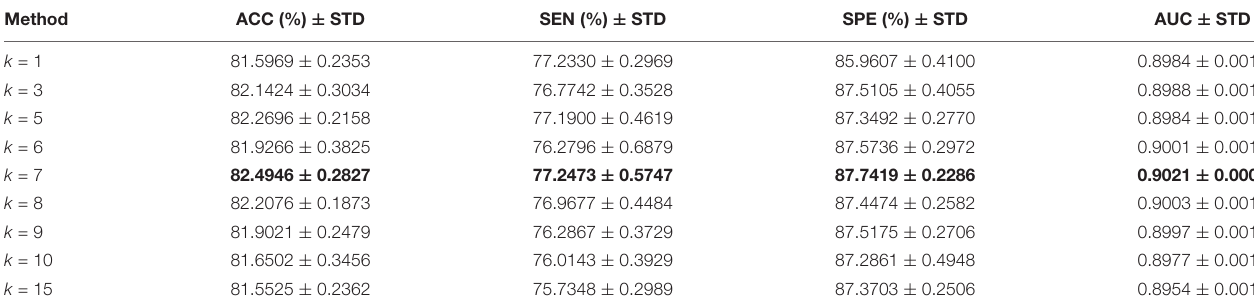
TABLE 3 | Classification performance of different neighbor